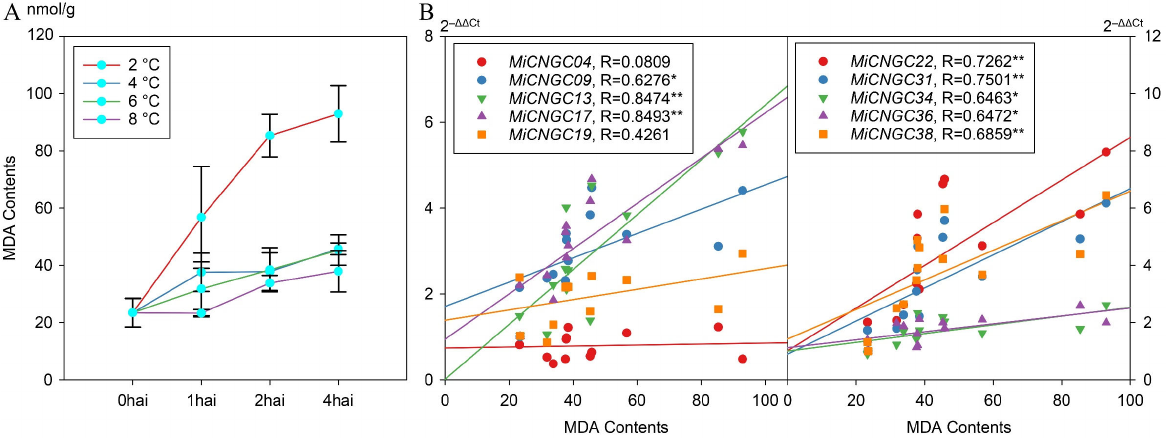
Figure 6. The MDA contents under cold stress of 2 (red), 4 (blue), 6 (green) and 8 °C (purple) in mango leaf ( A ) and their correlations with the relative expression levels of CNGC genes ( B ). * and ** represent that the correlation coefficients are significant at 0.05 (R > 0.532) and 0.01 (R > 0.661) levels, respectively.